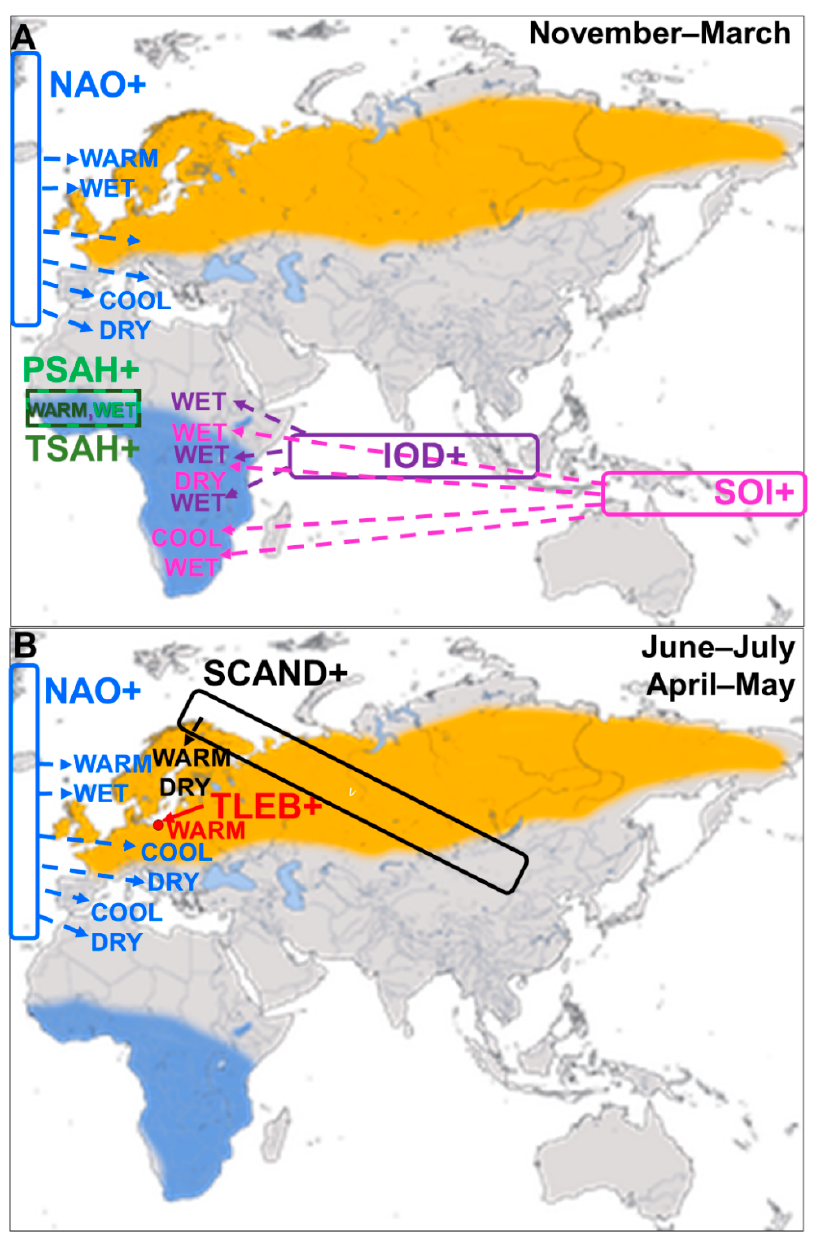
Figure 4. The approximate conditions at areas visited by the long-distance Euro-African migrants related with the positive phases of the analysed atmospheric patterns: ( A ) in November–March at both hemispheres, ( B ) in March–April and June–July at the northern hemisphere. Rectangles join the opposite centres of each climate pattern. Arrows and their labels indicate approximate areas influenced by each pattern and related conditions. Symbols of the climate indices as in Table 1. The climate indices are shown in relation to the geographical range of an example of a long-distance migrant, the Willow Warbler Phylloscopus trochilus (map by Andreas Trepte after [55], modified). The negative phases have opposite effects on the environment.